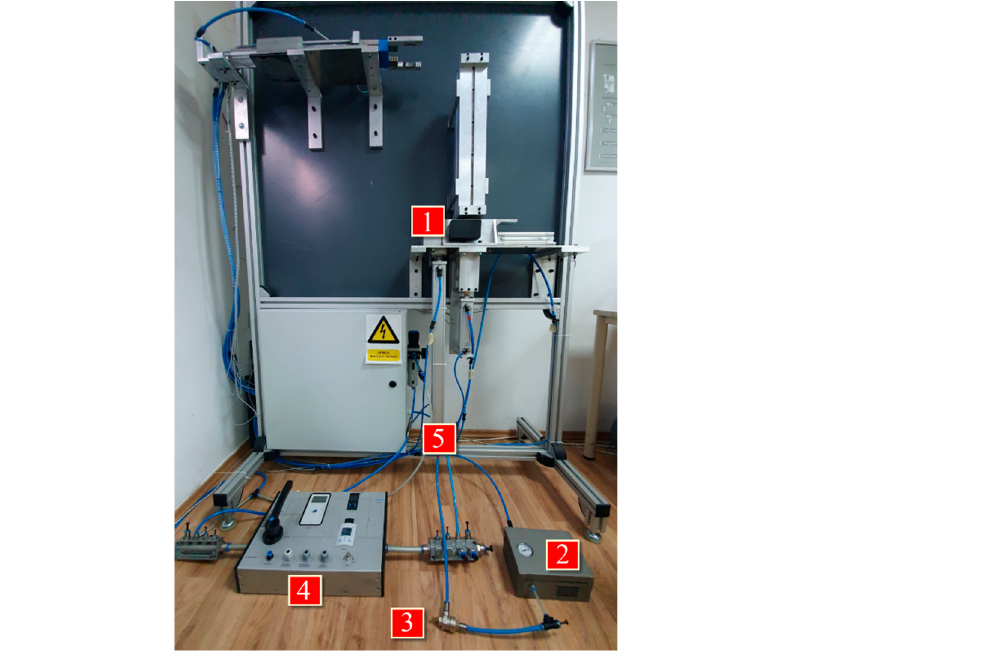
Figure 10. Integrated experimental setup: (1) RFID sensor assembly, (2) Developed pressure regulator, (3) A quick exhaust valve, (4) Festo AirBox, and (5) Cylinder C.